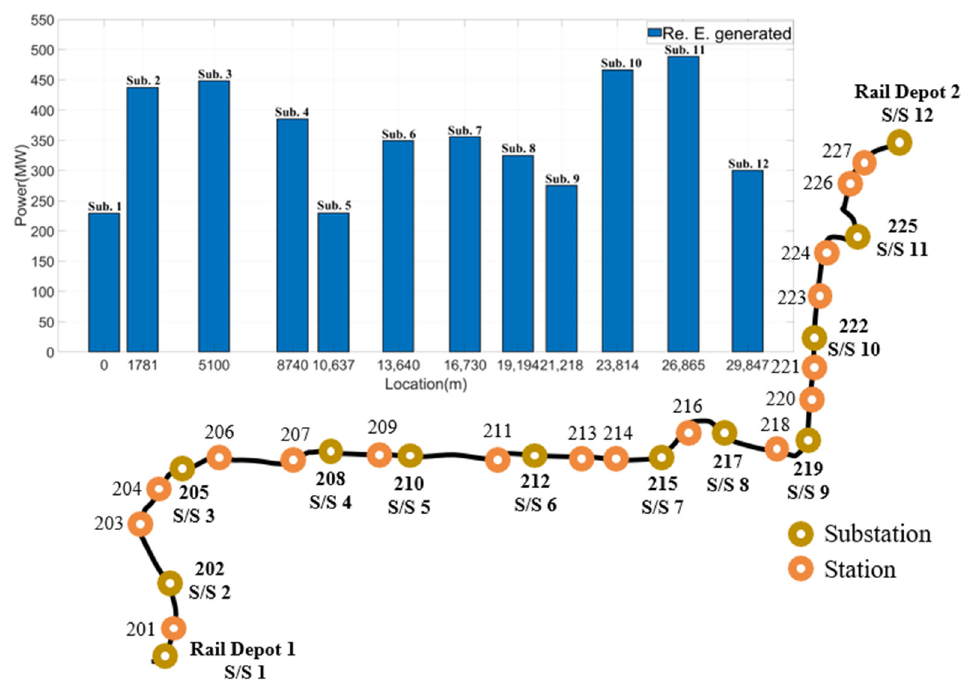
Figure 5. Regenerative energy generated by each substation per hour in 2nd Incheon line and its station and substation locations.